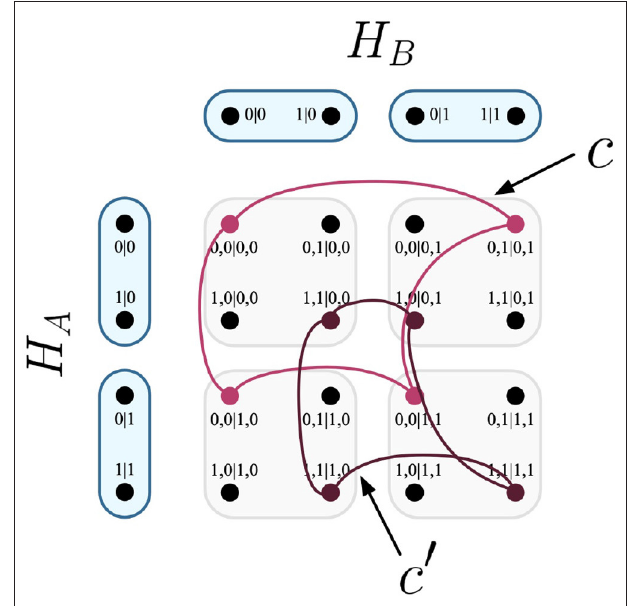
FIGURE 9 | The cliques c and c ′ visualized on Cartesian product of contextuality scenarios H A and H B .